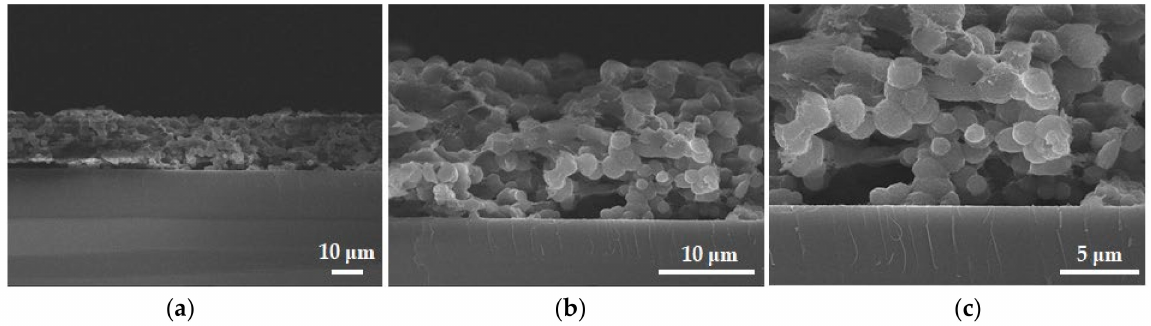
Figure 3. Cross-sectional SEM images of carbonaceous film on Si wafer; ( a ) 1000 × ; ( b ) 3000 × ; ( c ) 5000 ×